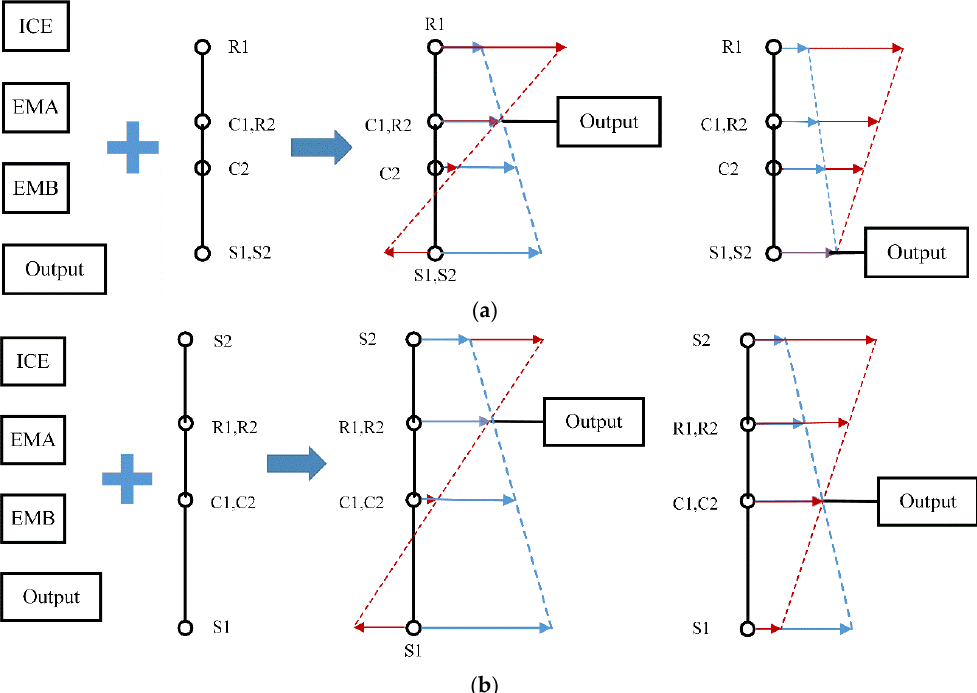
Figure 5. ( a ) Feasible connections of the output shaft and speed relationship of the Simpson 2 ‐ PG; ( b ) Feasible connections of the output shaft and speed relationship of the Ravigneaux 2 ‐ PG.